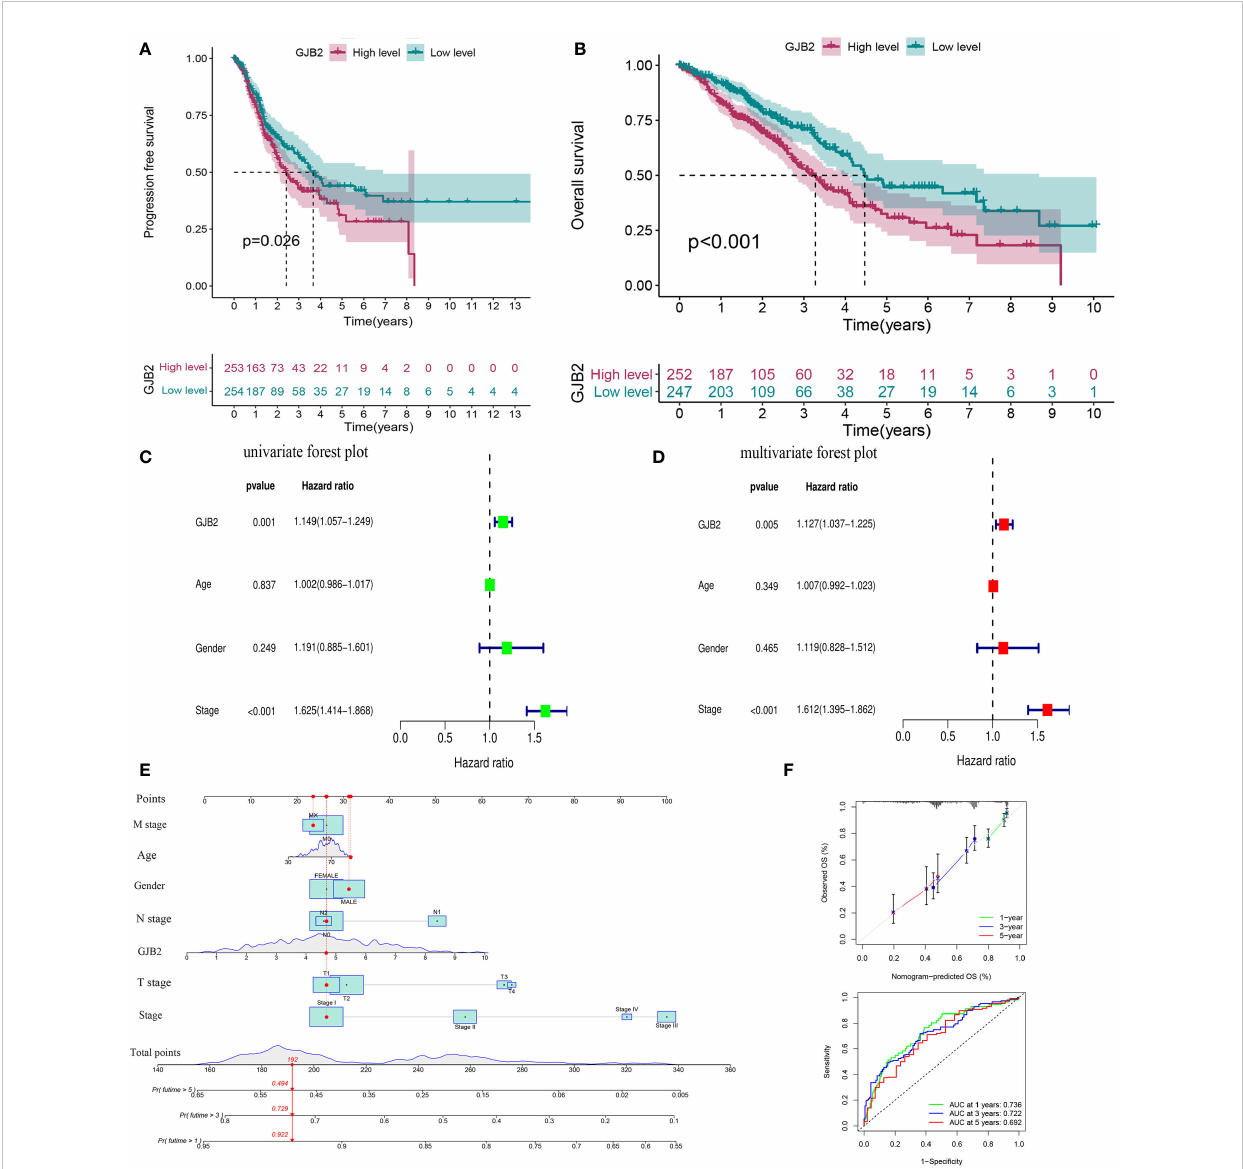
FIGURE 3 Prognostic value of GJB2 in LUAD. (A) Progression-free survival curve based on TCGA-LUAD. (B) Overall survival curve based on TCGA-LUAD. (C) Univariate Cox regression analysis of prognosis-related risk factors. (D) Multivariate Cox regression analysis of prognosis-related risk factors. (E) A nomogram for predicting survival of LUAD. (F) A calibration curve and ROC curve for the nomogram